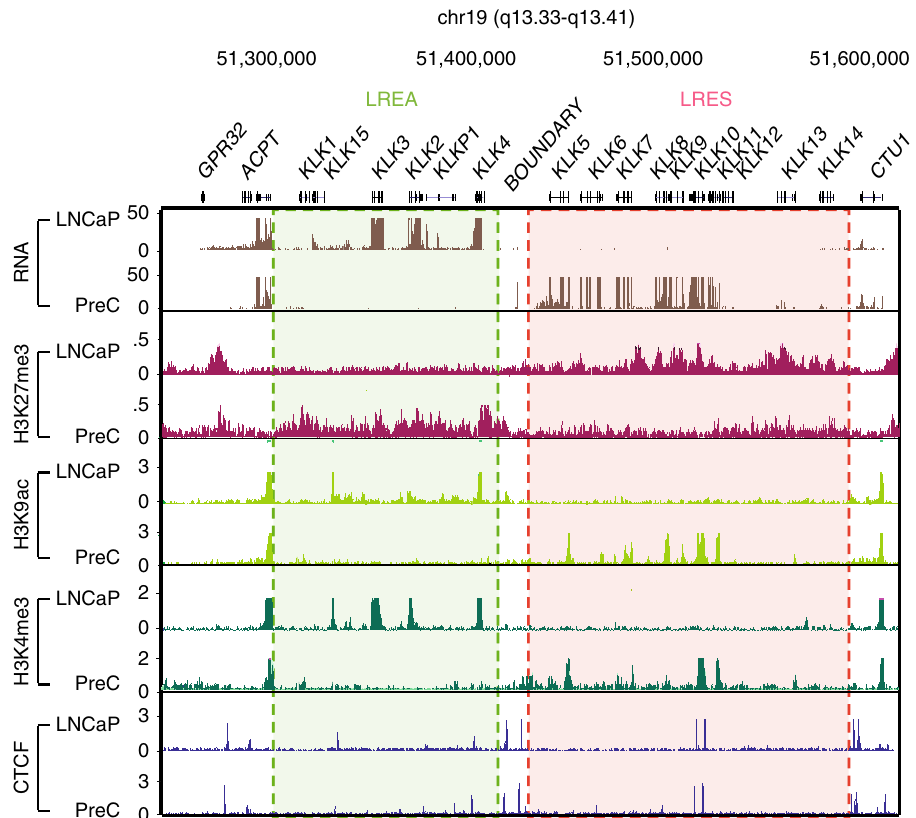
Fig. 1 Epigenome map of the Kallikrein locus in prostate cells. RNA-seq and ChIP-seq (H3K27me3, H3K9ac, H3K4me3 and CTCF) pro fi les of adjacent, transcriptionally active (green highlight) and silenced (red highlight) regions in LNCaP cancer cell line and normal PrEC cells. CTCF ChIP-seq shows CTCF binding throughout the locus. Two CTCF sites are located at the boundary between the active and silenced